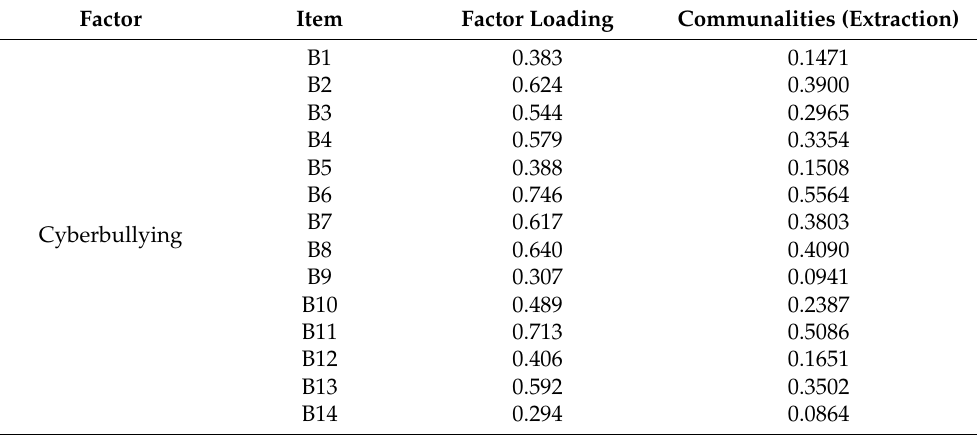
Table 2. Factor loadings, communalities, and item complexities of the CBS-M with the one-factor model.